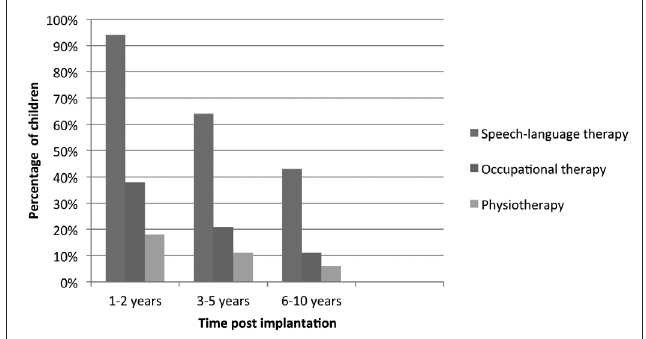
Fig. 3. Rehabilitation services received by children at different time intervals following